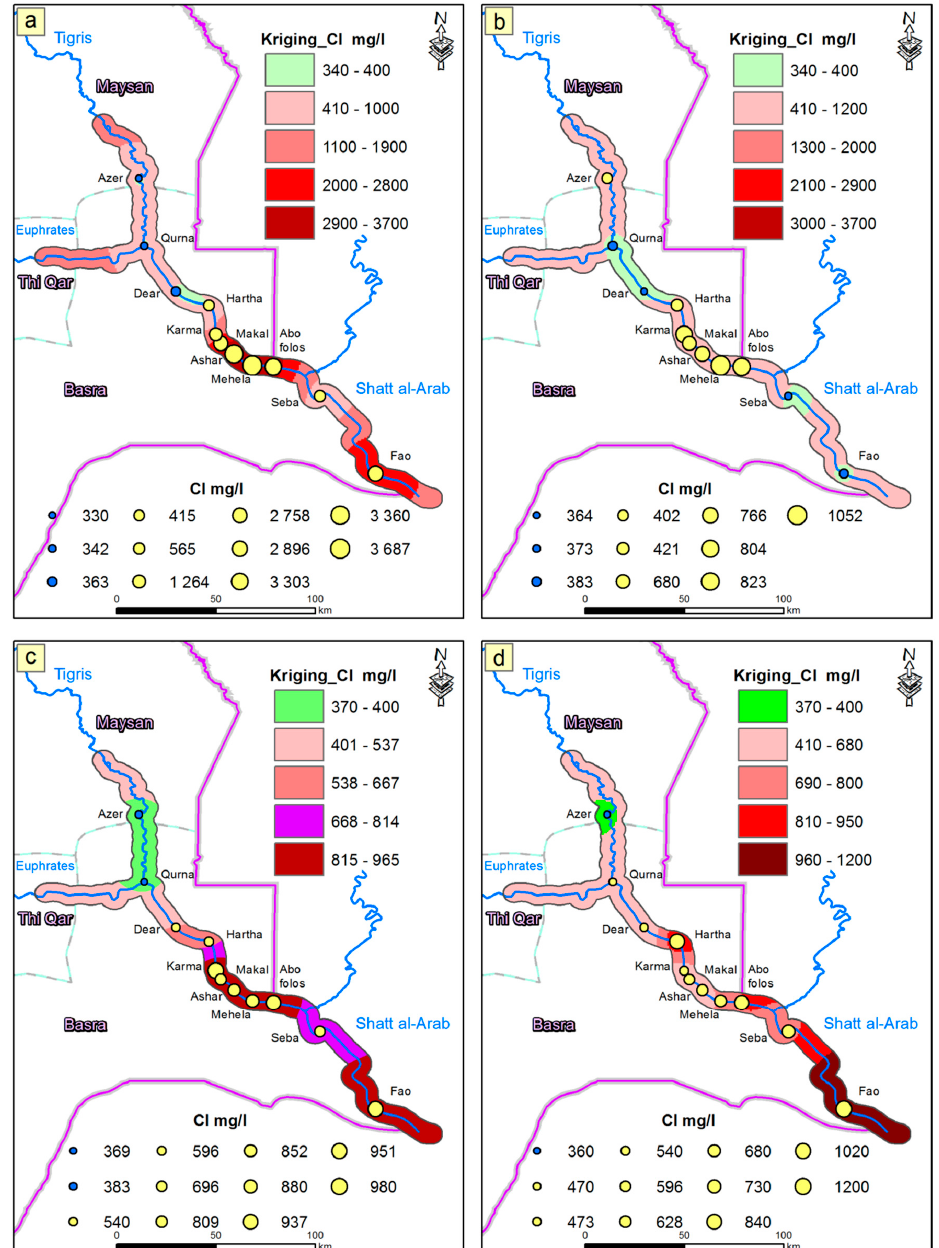
Figure A1. Spatial distributions of Cl concentrations by kriging ( a ) winter 2018 ( b ) spring 2019 ( c ) summer 2019 ( d ) autumn 2019.